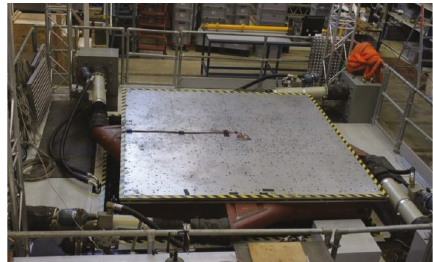
Figure 1: The hydraulic shaking